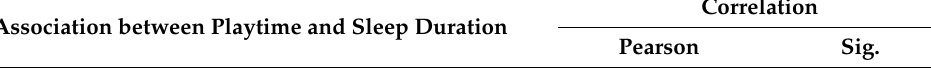
Correlation Pearson